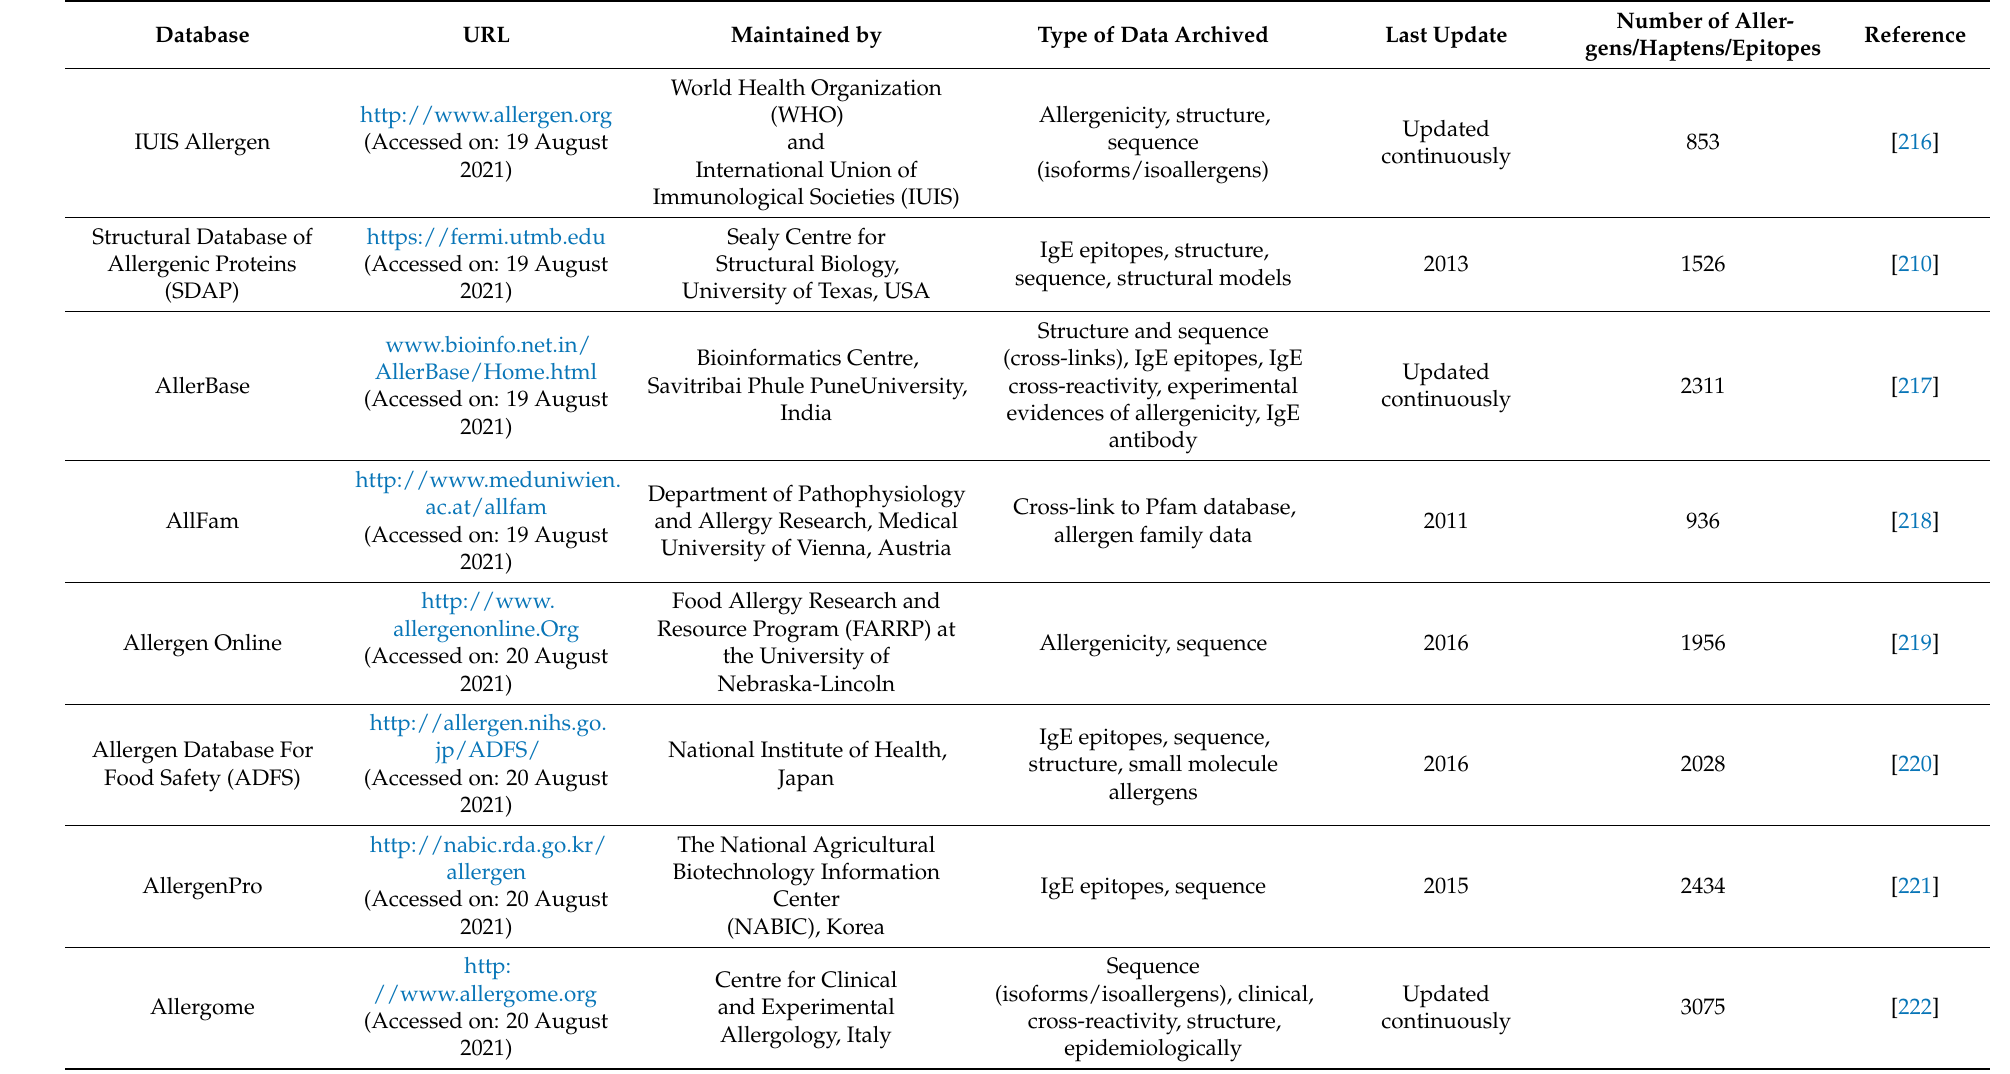
Table 2. Details of allergen-specific